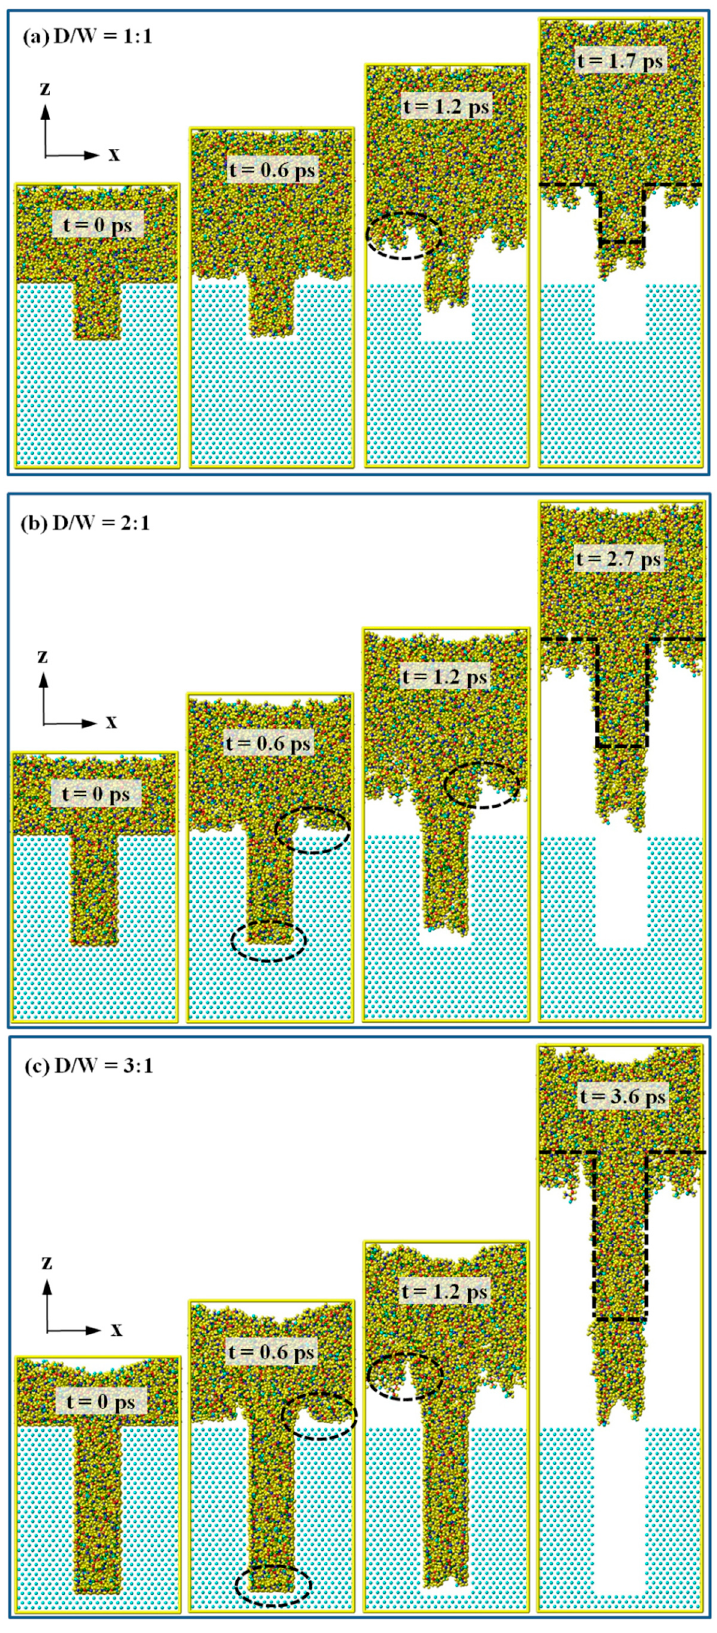
Figure 2. Snapshots of the PP nanostructure during the demolding process, with the D/W of these nano-cavities of ( a ) 1:1, ( b ) 2:1, and ( c ) 3:1, respectively.